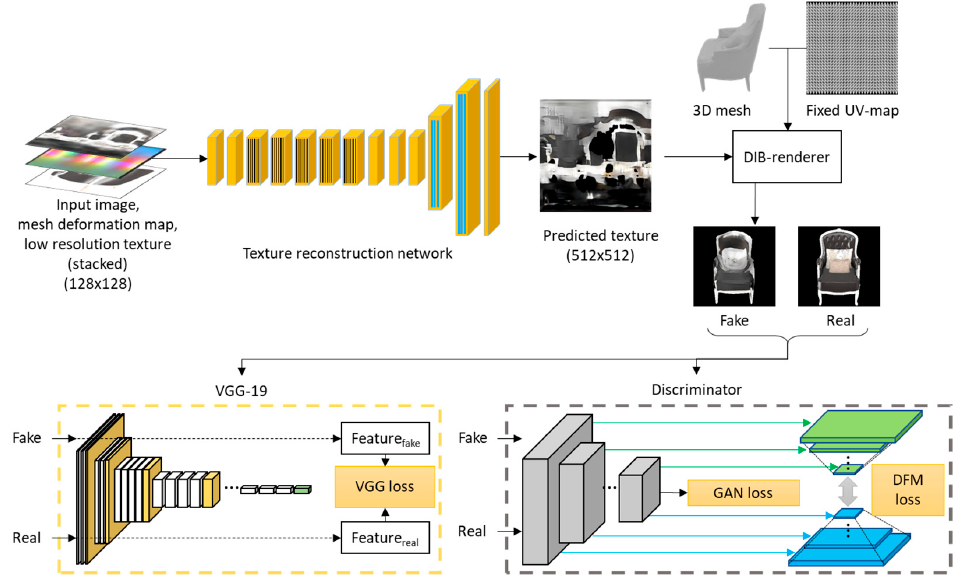
Figure 3. Training process of texture-reconstruction network.